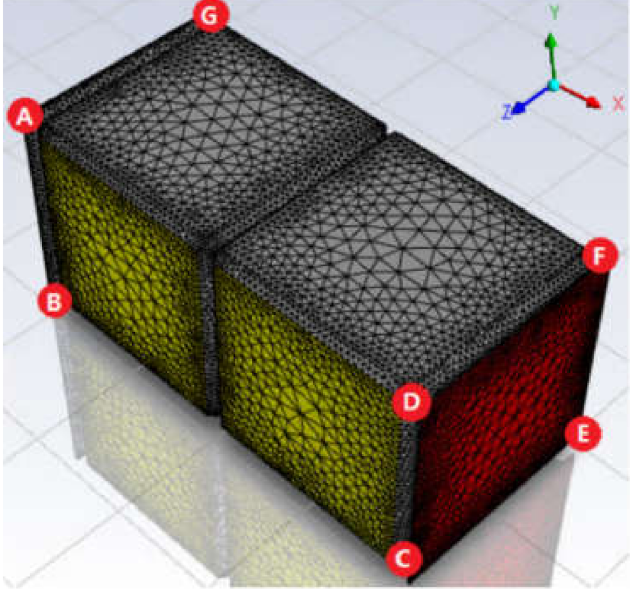
Figure 5. Inner fluid model of grid lattice